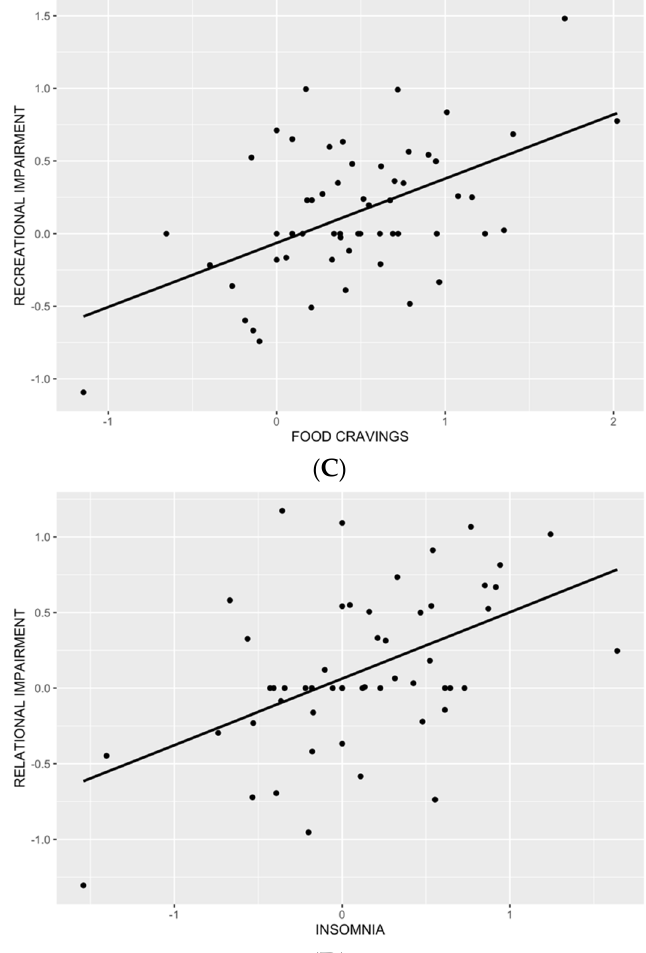
Figure 2. Scatterplot of a significant relationship between occupational impairment and insomnia ( p = 0.00096; ( A )), recreational impairment and insomnia ( p = 0.000586; ( B )), recreational impairment and food cravings ( p = 0.020611; ( C )), and relational impairment and insomnia ( p = 0.00554; ( D